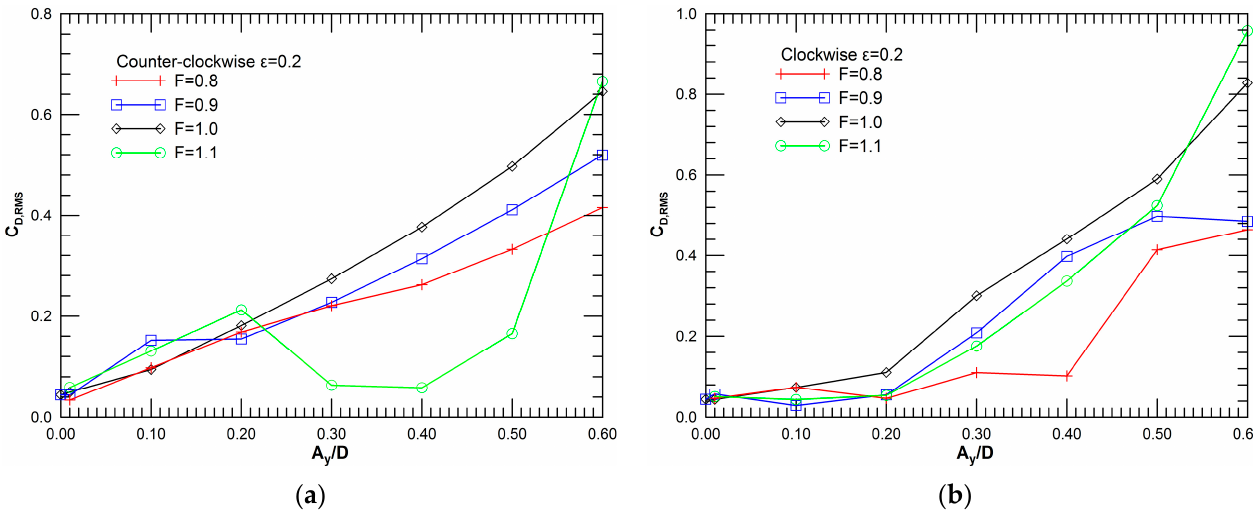
Figure 6. Variation of the RMS of the drag coefficient, C D,RMS , for ε = 0.2, versus the non-dimensional amplitude A y /D, for frequency ratio F = 0.8, 0.9, 1.0, 1.1: ( a ) counter-clockwise cylinder oscillation, ( b ) clockwise cylinder oscillation.